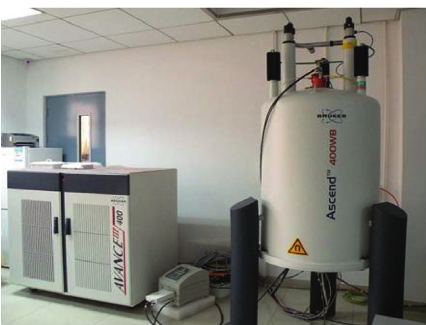
Figure 3: BRUKER AVANCE III 400 nuclear magnetic resonance